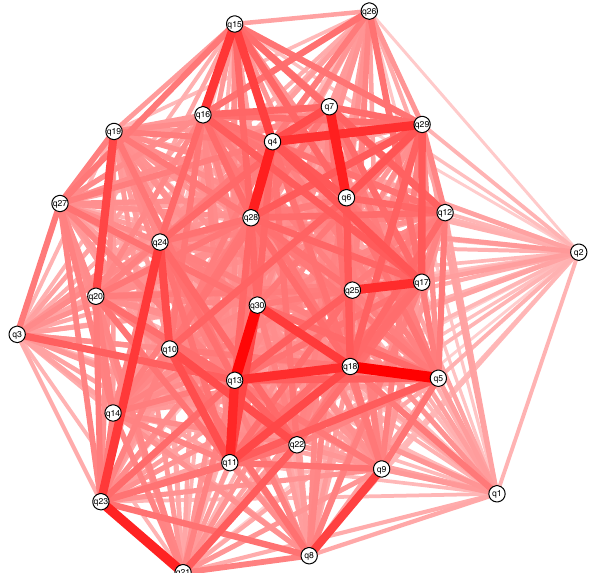
FIG. 1. The network of all FCI questions is shown. The strength of connection between questions is based on Cram´er ’ s V statistics, with a minimal threshold of 0.05. The thicker the lines, the stronger the association between